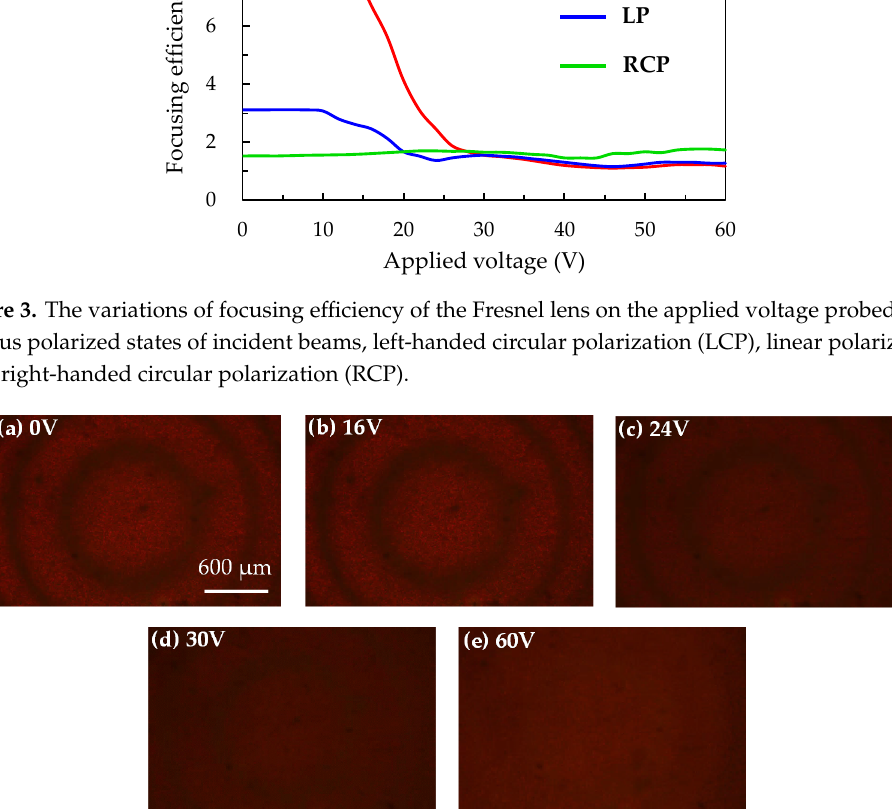
Figure 4. The optical microscopic images of the Fresnel-like pattern in the ADDCLC sample under various applied voltages of: ( a ) 0 V, ( b ) 16 V, ( c ) 24 V, ( d ) 30 V, and ( e ) 60 V, respectively.